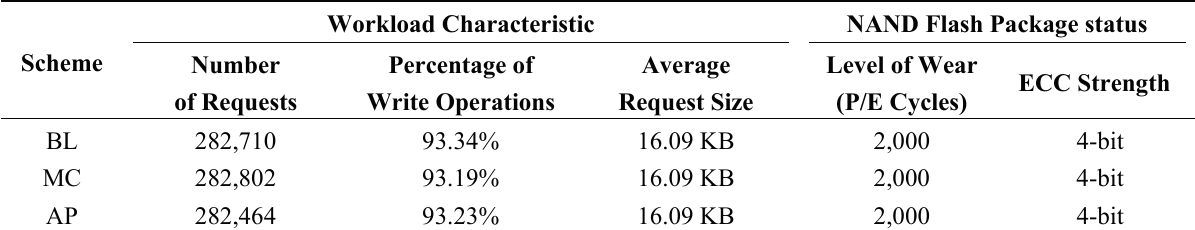
Table 3. The characteristic of the workload and the status of Micron 29F64GCBAAA NAND flash memory of Baseline, Meta-Cure, and Asymmetric Programming (BL: Base Line; MC: Meta-Cure; AP: Asymmetric